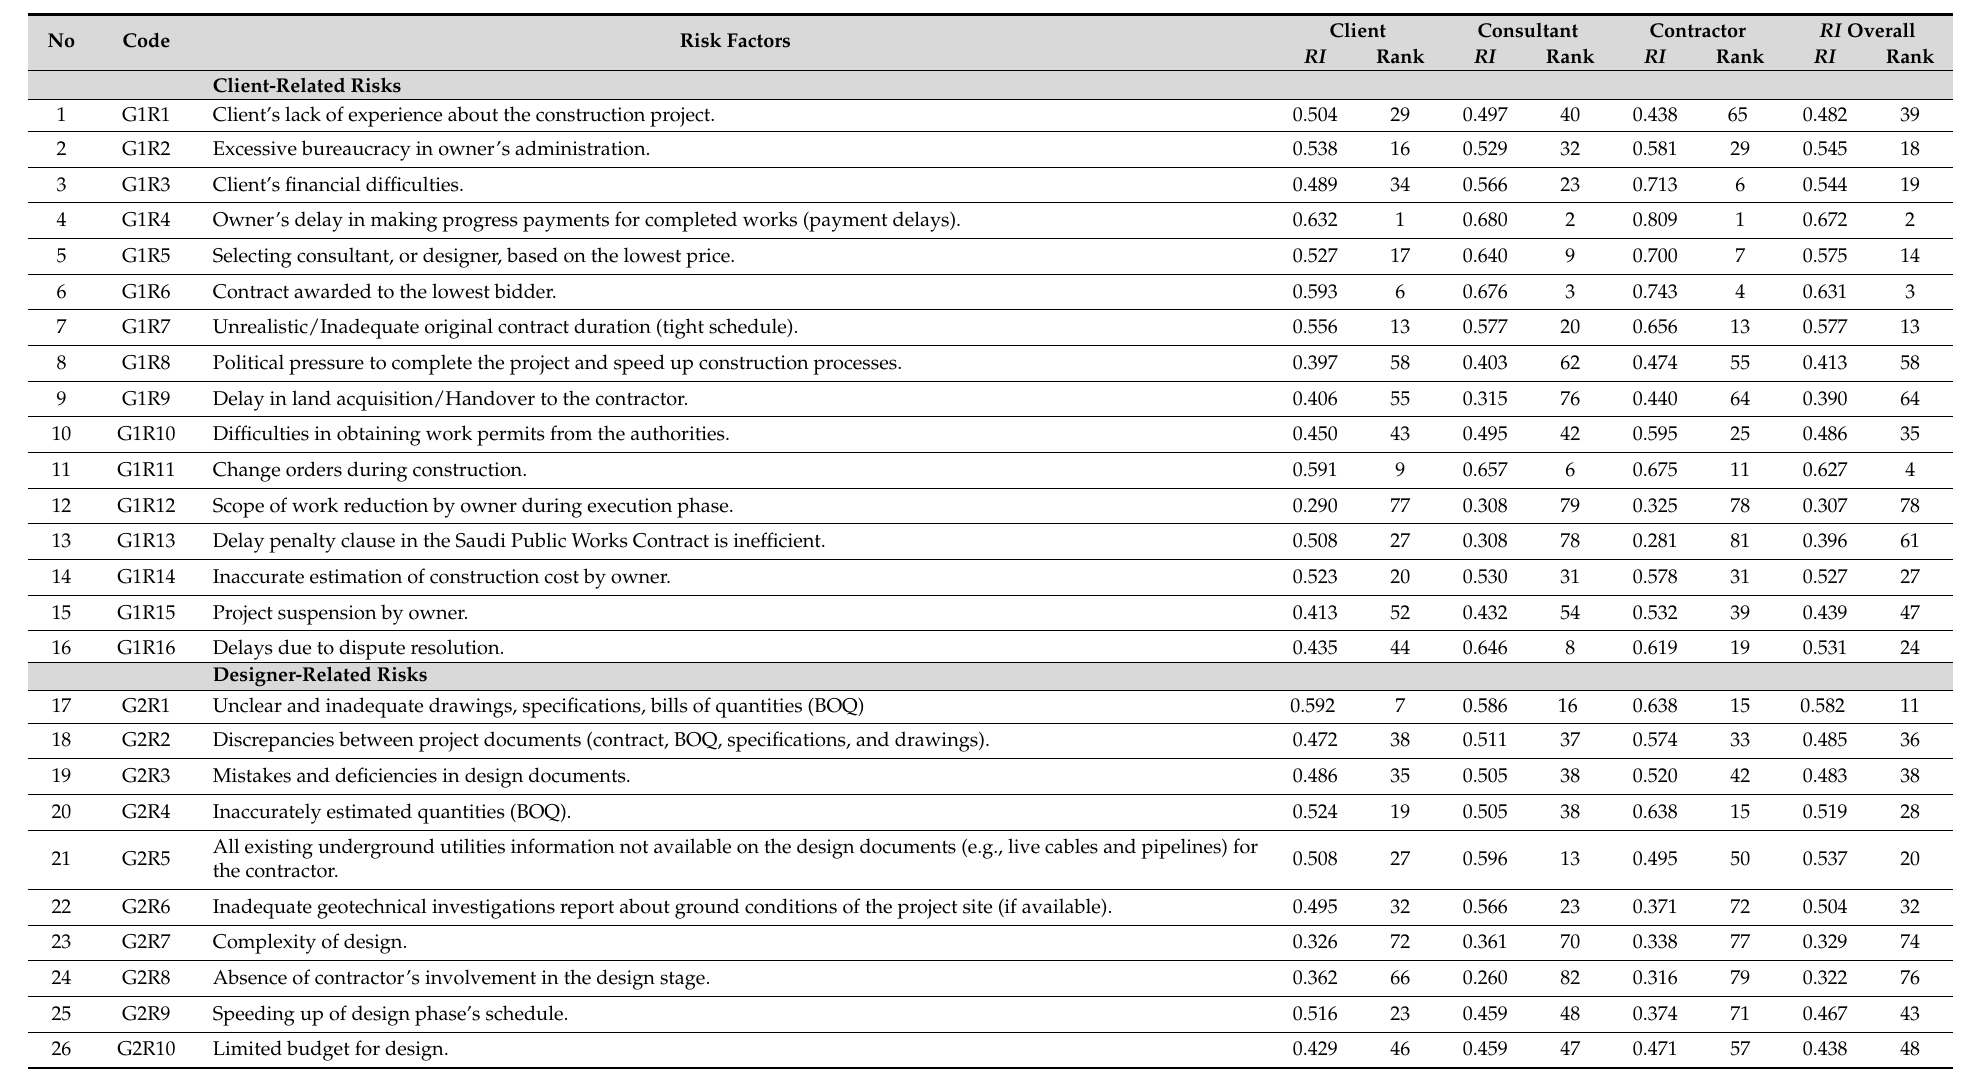
Table A3. Risk Importance (RI) for risk factors of building construction projects and ranking, according to the perspective of the three groups of respondents. Client Consultant Contractor RI Overall No